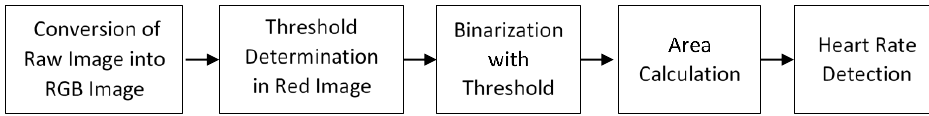
Figure 7. Procedure of the fingertip image intensity-based detection method.